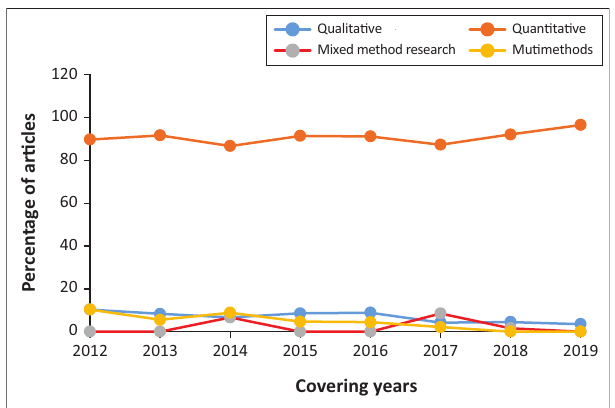
FIGURE 2: Methodological trends in the Journal .